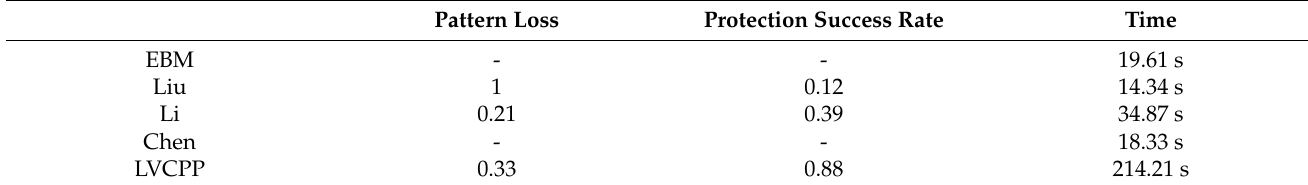
Table 3. Comparison of the proposed method with state-of-the-art methods.